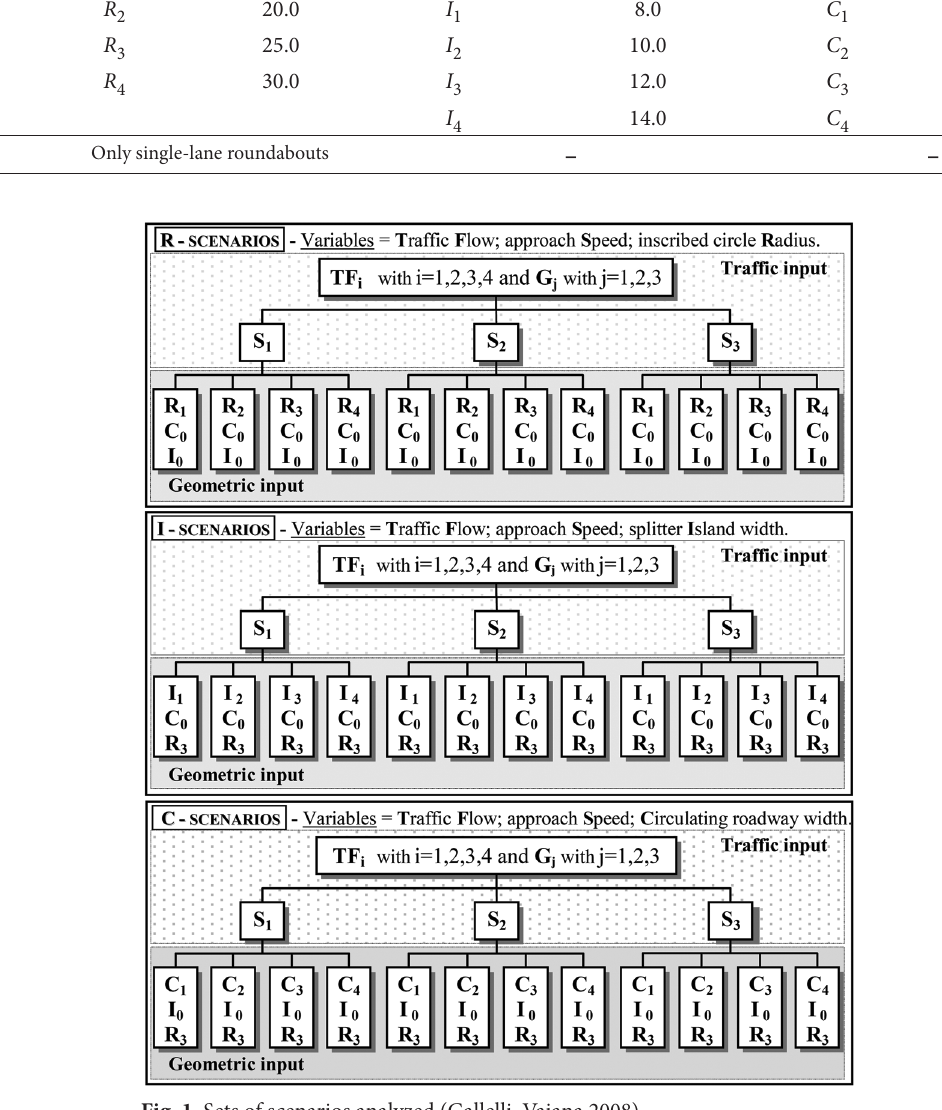
Fig. 1. Sets of scenarios analyzed (Gallelli, Vaiana